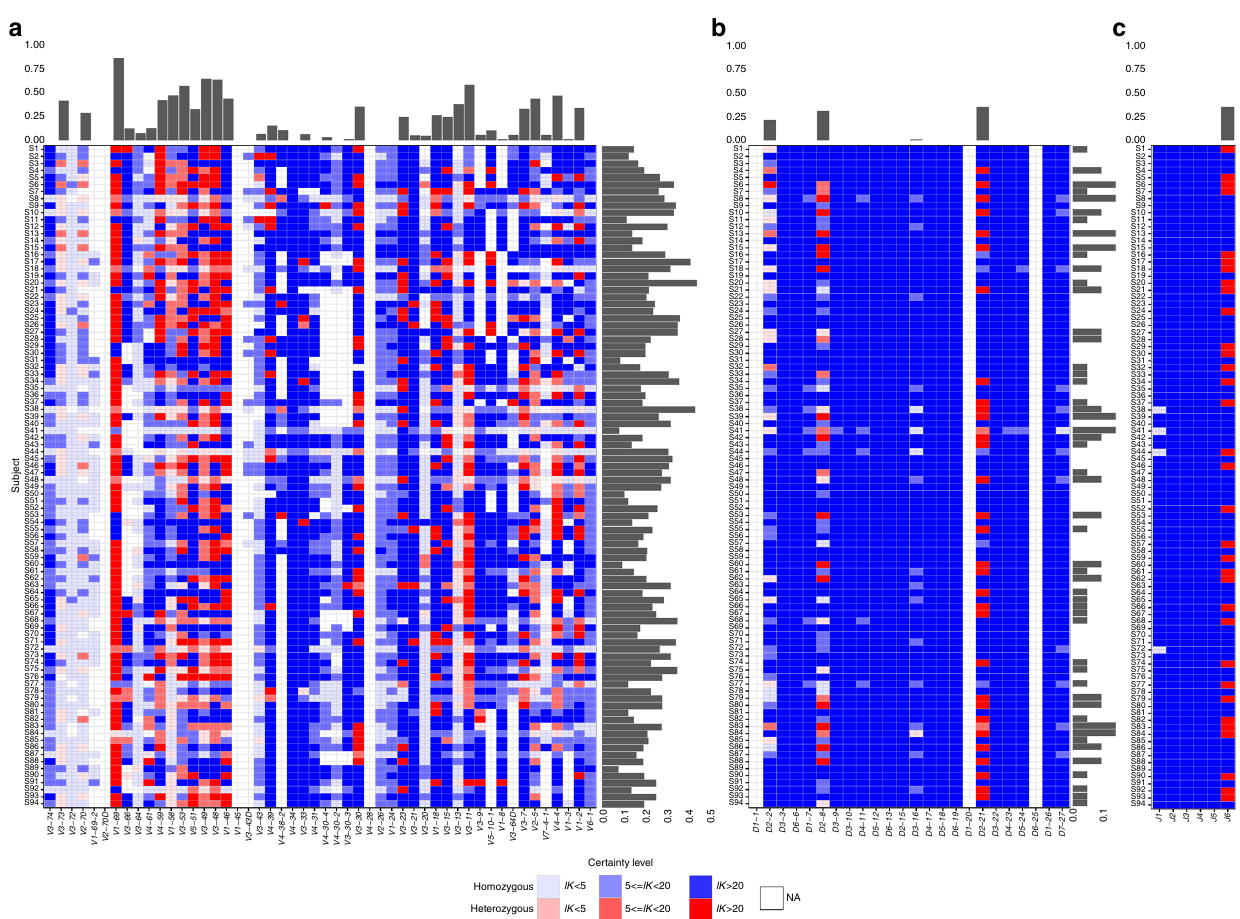
Fig. 3 Heterozygosity of the IGH genes. Each row represents an individual, and each column represents a V gene ( a ), D gene ( b ), and J gene ( c ). Red shades represent heterozygous genes, and blue shades represent homozygous genes. Transparency corresponds to the certainty level of genotype inference. White represents a gene with too low usage (fewer than 10 sequences, marked as NA) to enable clear genotype inference. Bars on top of each panel represent the ratio between the number of individuals with heterozygous genes and all individuals with a de fi ned genotype for this gene. Bars on the side of each panel represent the fraction of heterozygous genes for each individual out of all genes with a de fi ned